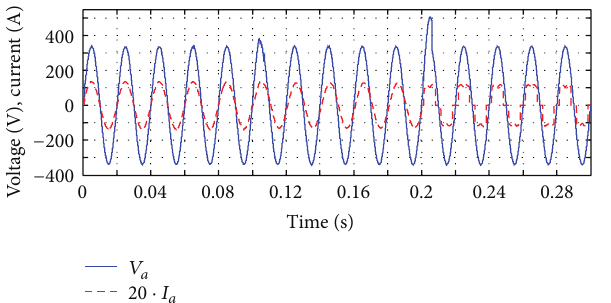
Figure25:Outputvoltageandcurrentloadoftheinverterwiththree load types.